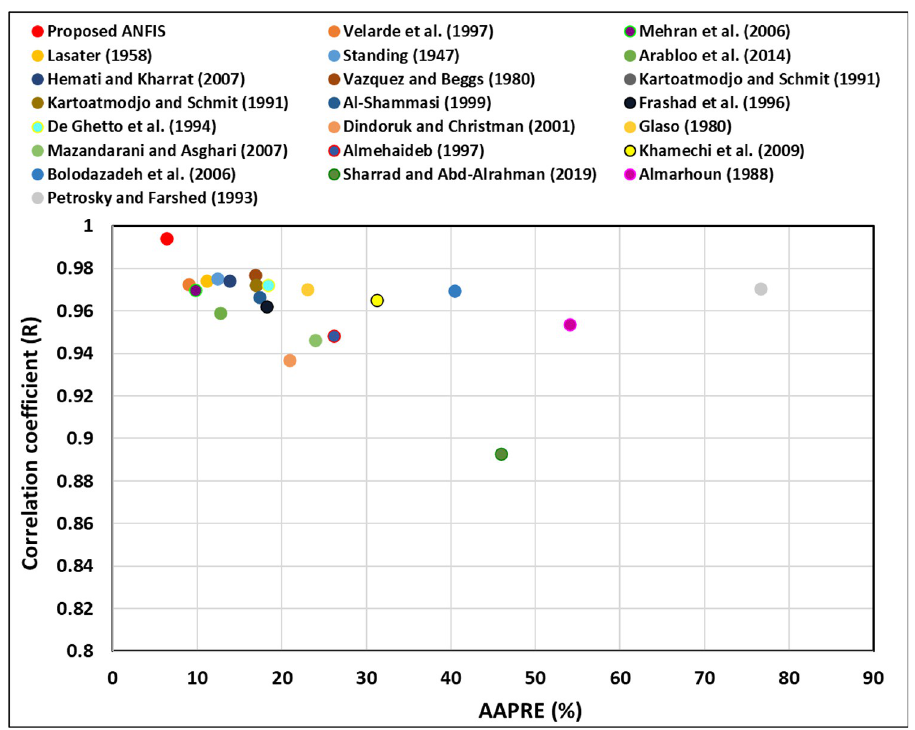
Fig 16. Comparing the ANFIS and existing models using (R) and AARE